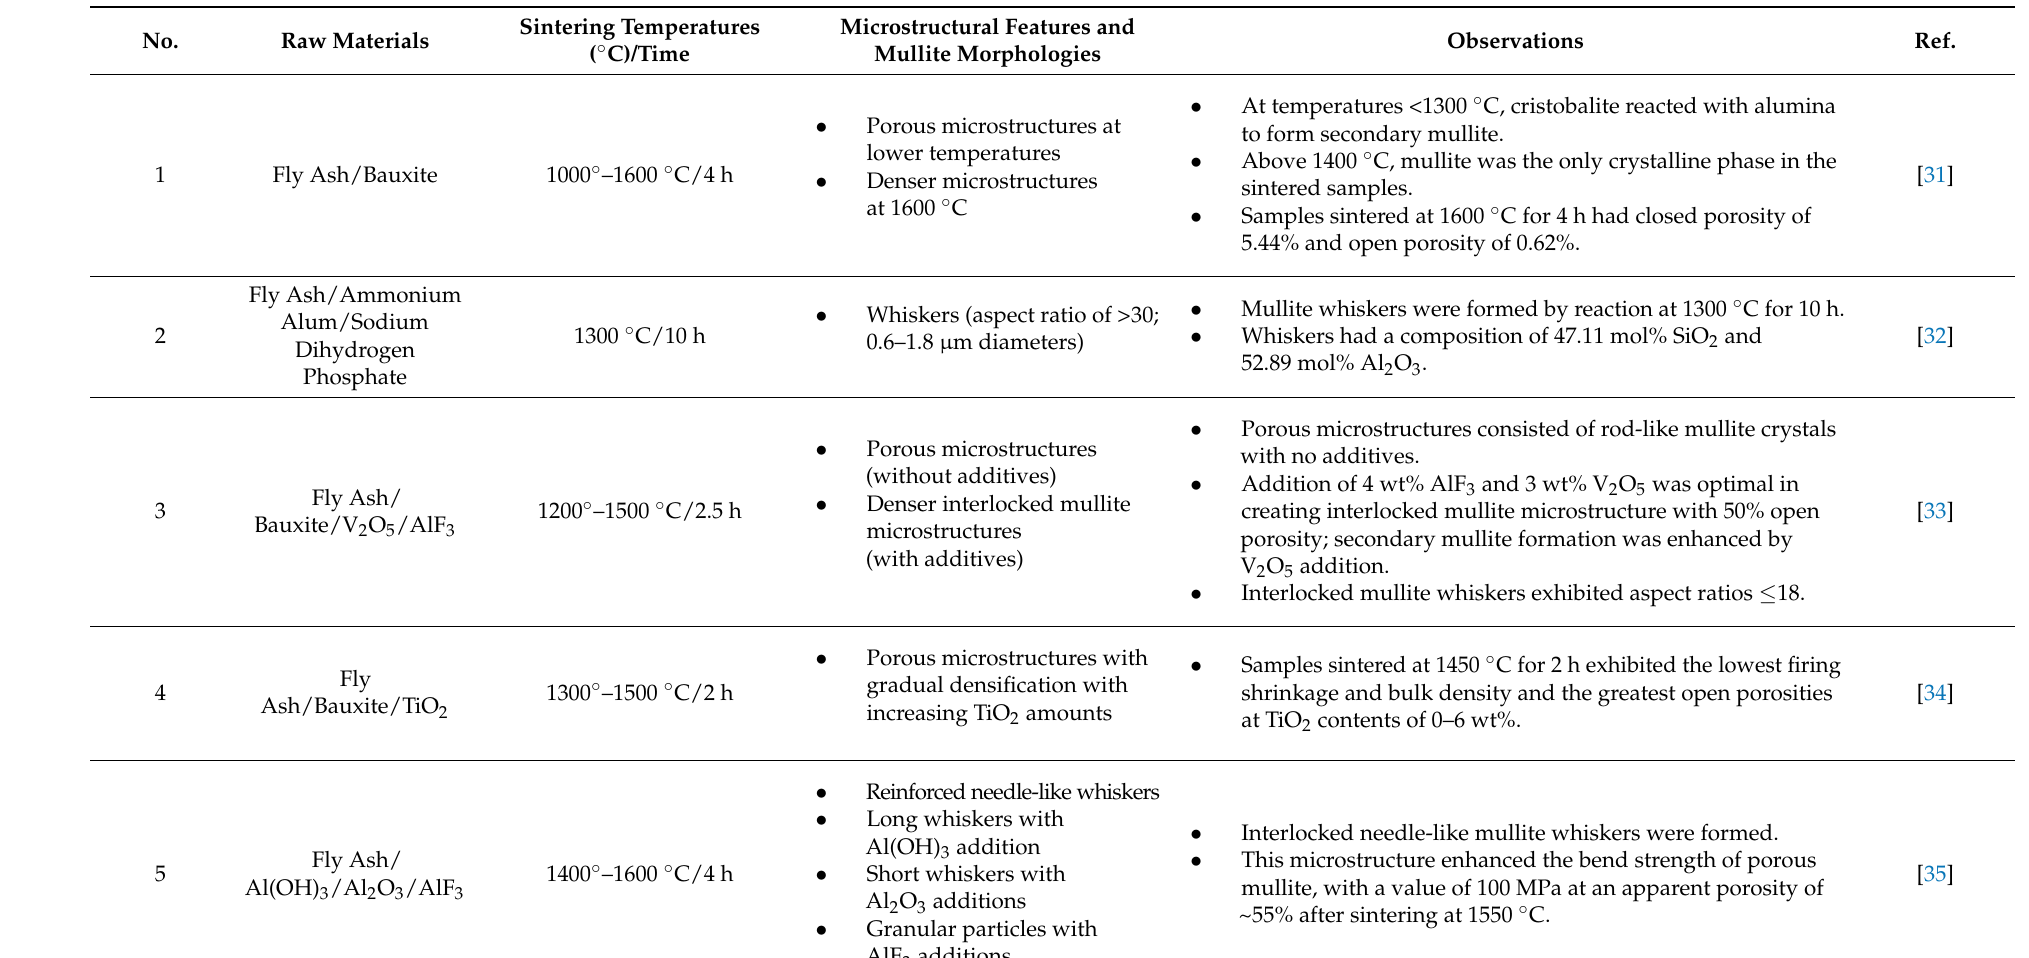
Table 1. Comprehensive summary of research on mullite production from fly